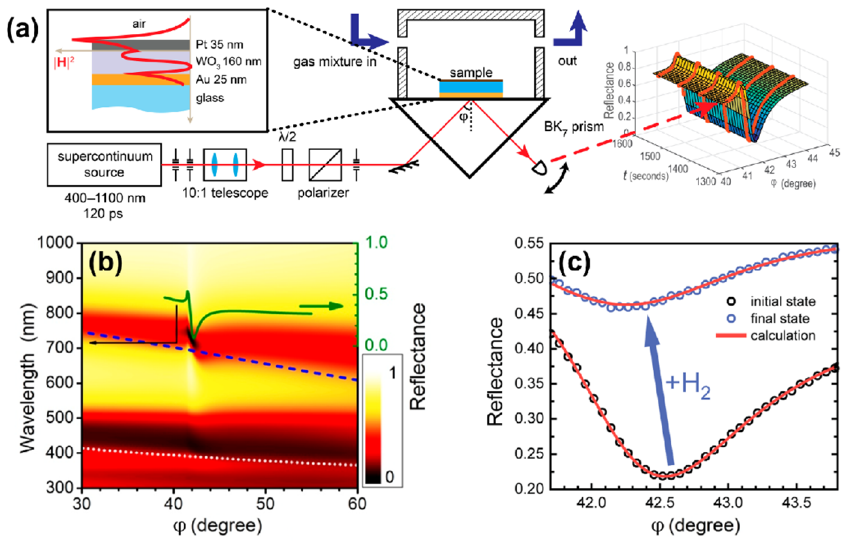
Figure 1. ( a ) Kretschmann scheme for measuring the optical response of tungsten trioxide to hydrogen. The inset shows the structure of the trilayer under study as well as the distribution of the magnetic field intensity in the presence of the p -polarized excitation wave at a wavelength of 705 nm. ( b ) Calculated angular and spectral map of reflectance for TM- ( p -) polarized wave; additionally, a reflectance curve at a wavelength of 705 nm is shown (solid green line). Dispersion curves for the first (dashed blue line) and the second (dotted light gray line) waveguide modes were calculated for the case of thick (200 nm) metal layers. ( c ) Change in the angular dependence of reflectance under exposure to 0.36% (3600 ppm) of hydrogen.